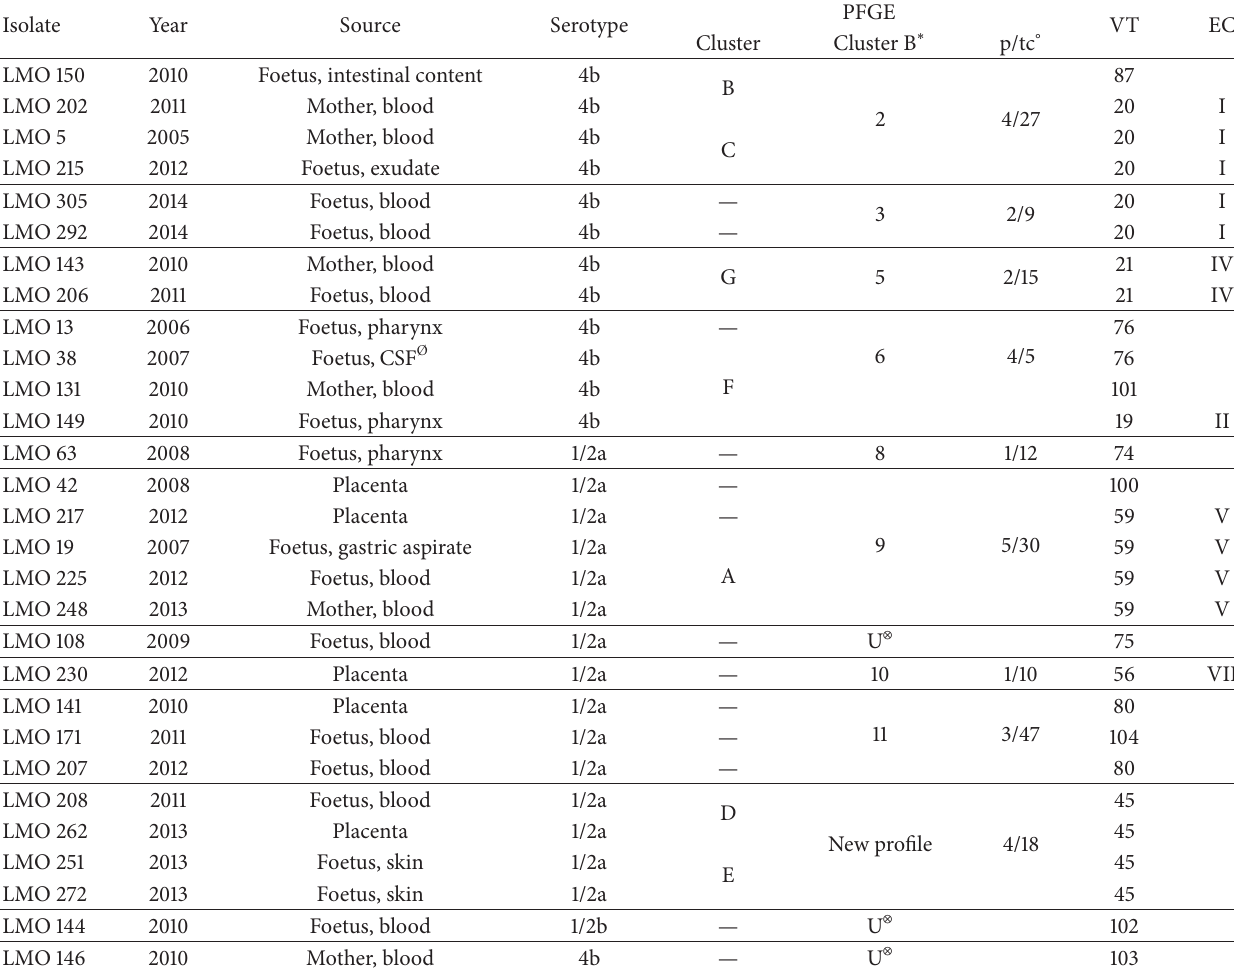
Table 2: Serotyping and molecular subtyping results for the 29 pregnancy-related isolates under study (2005–2014, Lombardy, Italy).